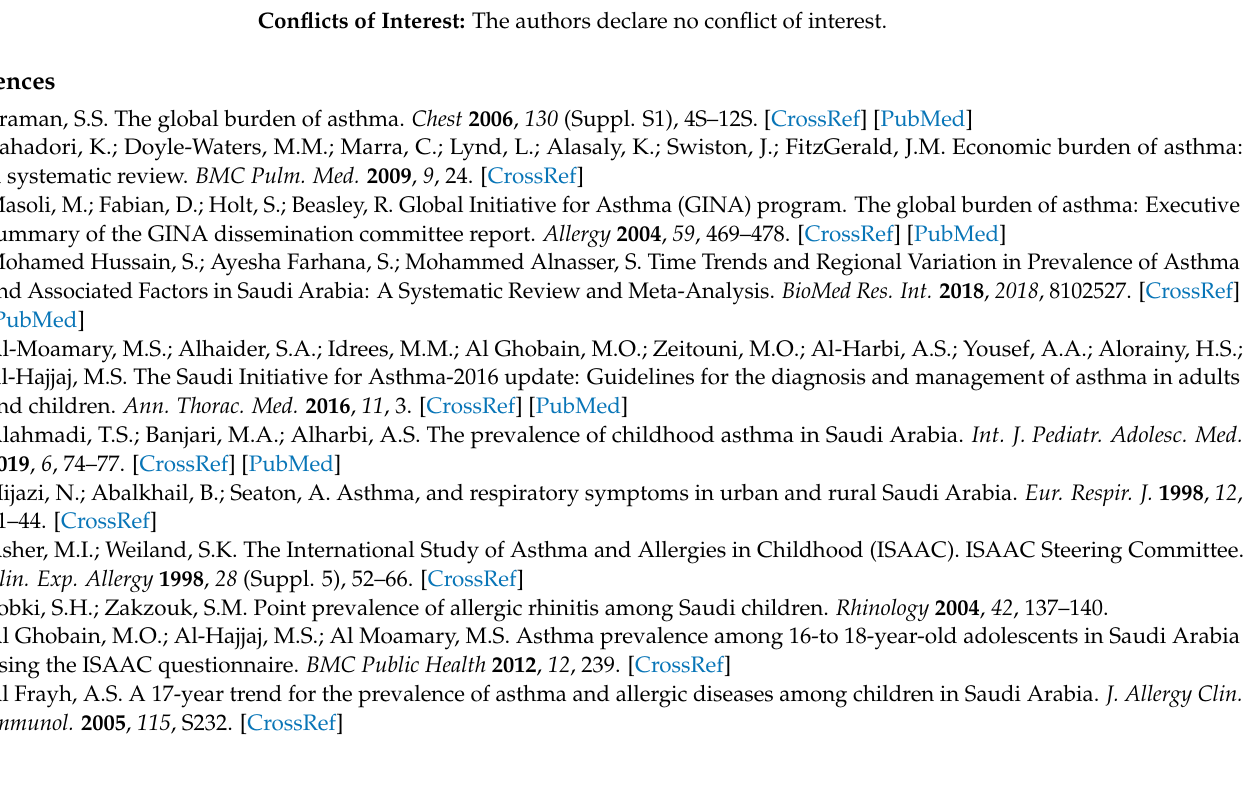
Table S2: Significant risk factors in univariate analysis which were associated with wheeze in the last 12 months in children and adolescents of Rabigh’s community; Table S3: Significant risk factors in univariate analysis which were associated with ever physician-diagnosed asthma in children and adolescents of Rabigh’s